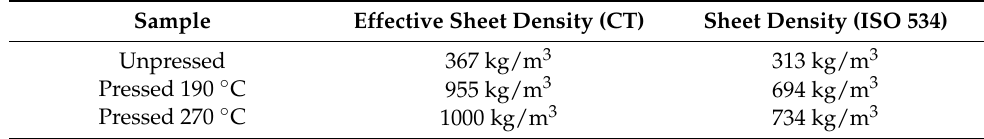
Table 1. Effective density of the TMP sheets obtained from the X-ray microtomography (CT) com- pared with the standard